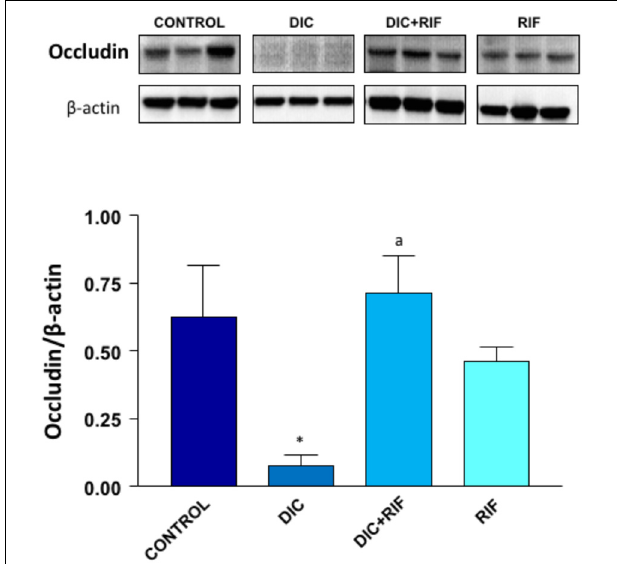
FIGURE 5 | Western blot analysis of occludin in the ileum of rats treated with vehicle (Control), diclofenac (DIC, 4 mg/kg BID), diclofenac plus rifaximin (DIC+RIF, 50 mg/kg BID), or rifaximin (RIF) for 14 days. Each column represents the mean ± SEM obtained from 10 animals. ∗ p < 0.05, significant difference versus Control; a p < 0.05, significant difference versus diclofenac alone.